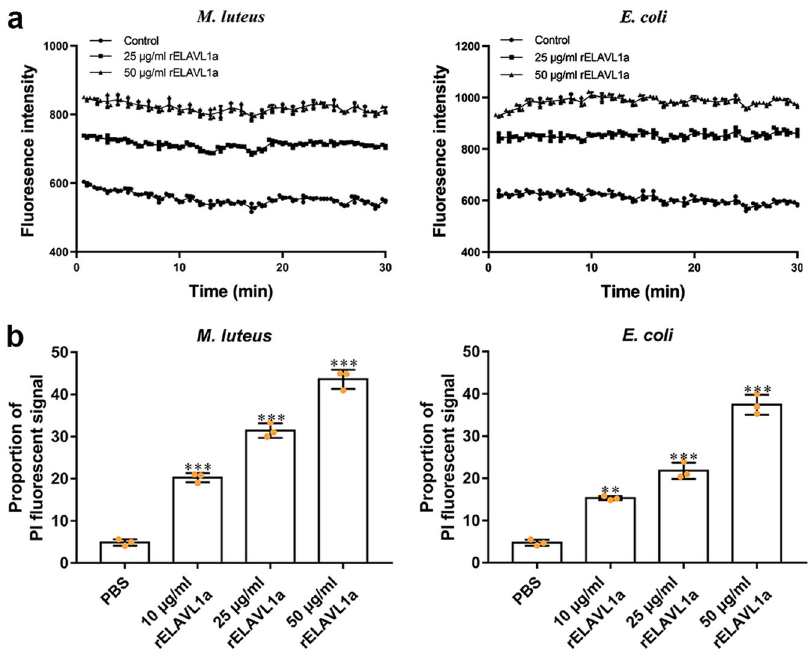
Fig. 5 rELAVL1a was able to disrupt the bacterial membranes by a membrane lytic mechanism including a combined action of membrane depolarization and membrane permeabilization. a The rELAVL1a caused depolarization of the bacterial plasma membrane. The changes in fl uorescence intensity were recorded with a Tecan GENios plus spectro fl uorometer at an excitation wavelength of 622 nm and an emission wavelength of 670 nm. Control, HEPES buffer containing 20 mM glucose. b The effects of rELAVL1a on the membrane integrity of M. luteus and E. coli , cells analyzed by fl ow cytometry. All data were expressed as mean values ± SD. ( n = 3). The data are from three independent experiments performed in triplicate. The bars represent the mean ± S.D. The signi fi cance of the difference was determined by one-way ANOVA. ** p < 0.01, *** p <